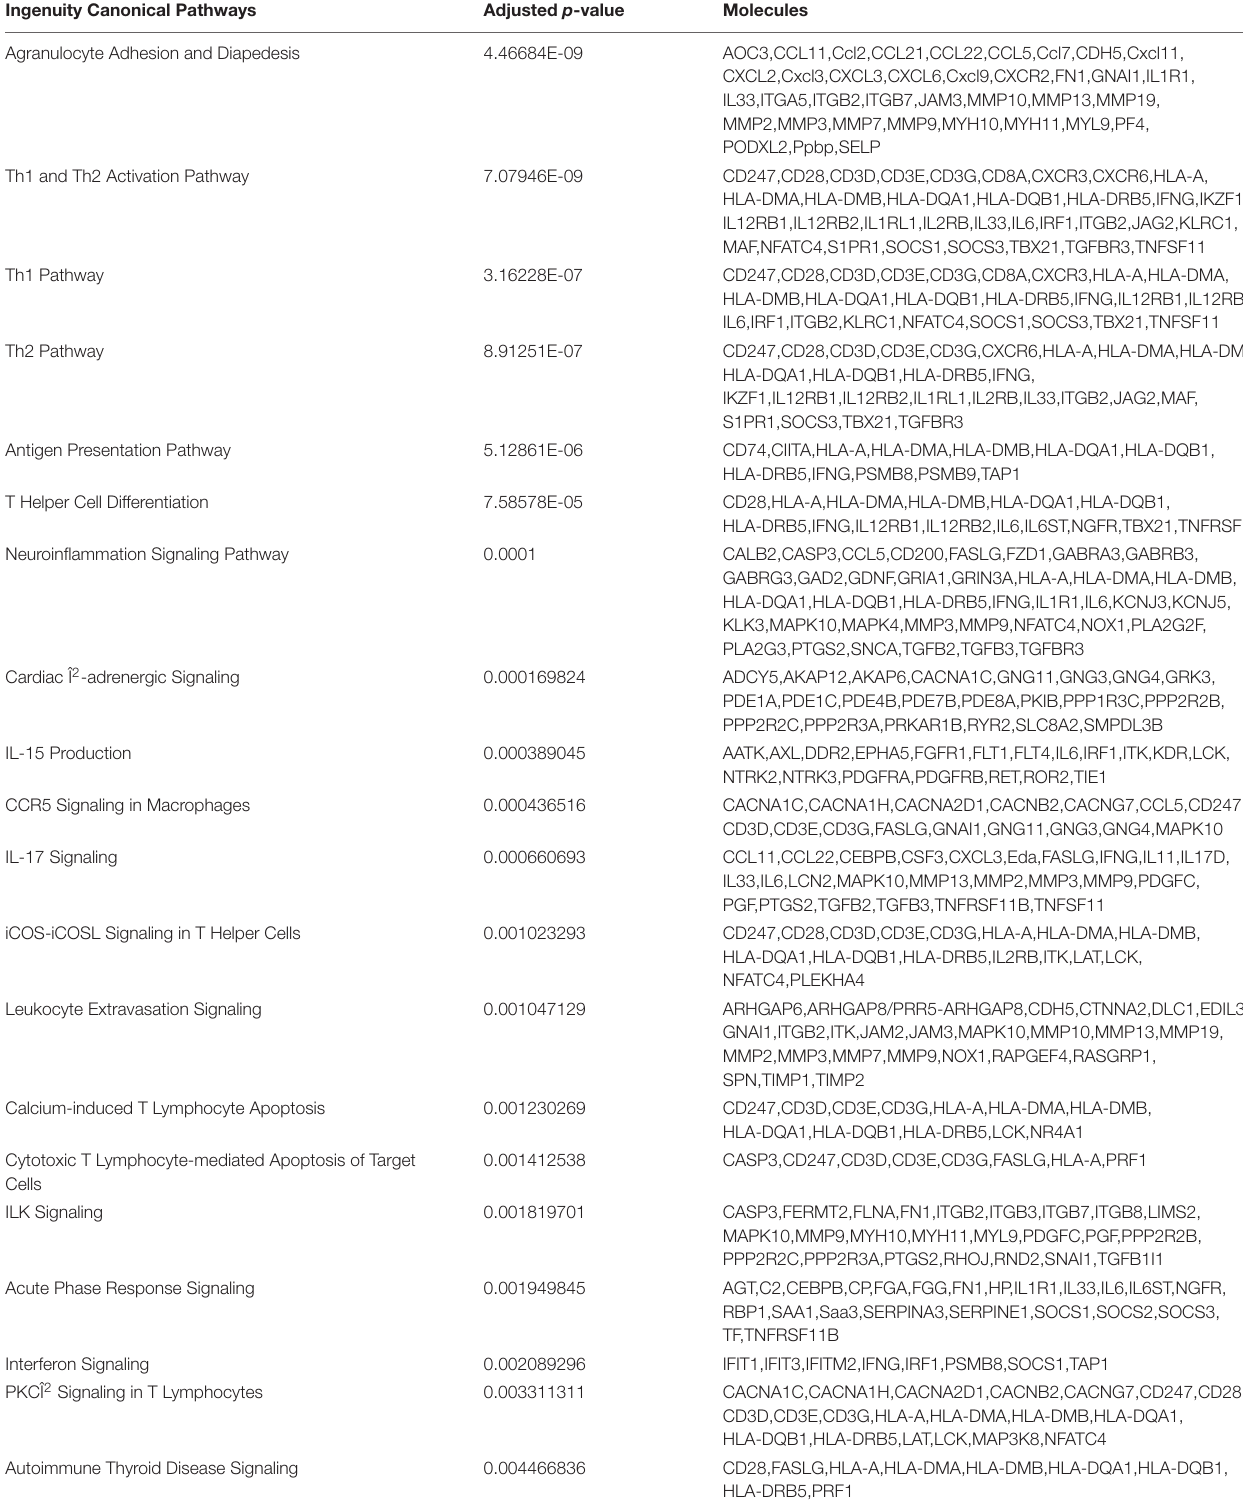
TABLE 5 | Effects of Mesalazine on the IPA canonical pathways. Ingenuity Canonical Pathways Adjusted p